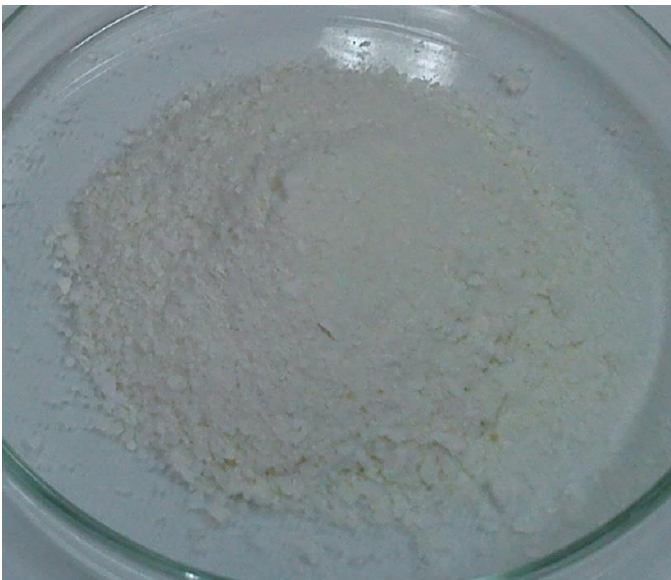
Figure 3. Dietary fiber ingredient obtained for the treatment nº 4. 𝐶 𝑁𝑎𝑂𝐻 = 0.419 M; 𝐶 𝐻 T = 2.81 h.